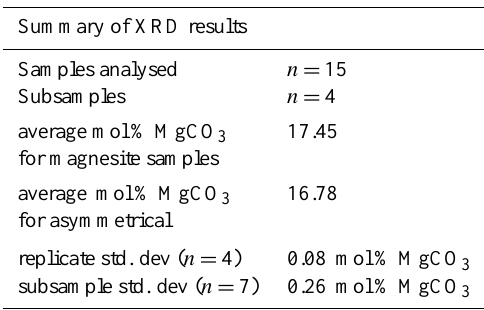
Table 1. Summary of XRD results, full details in the